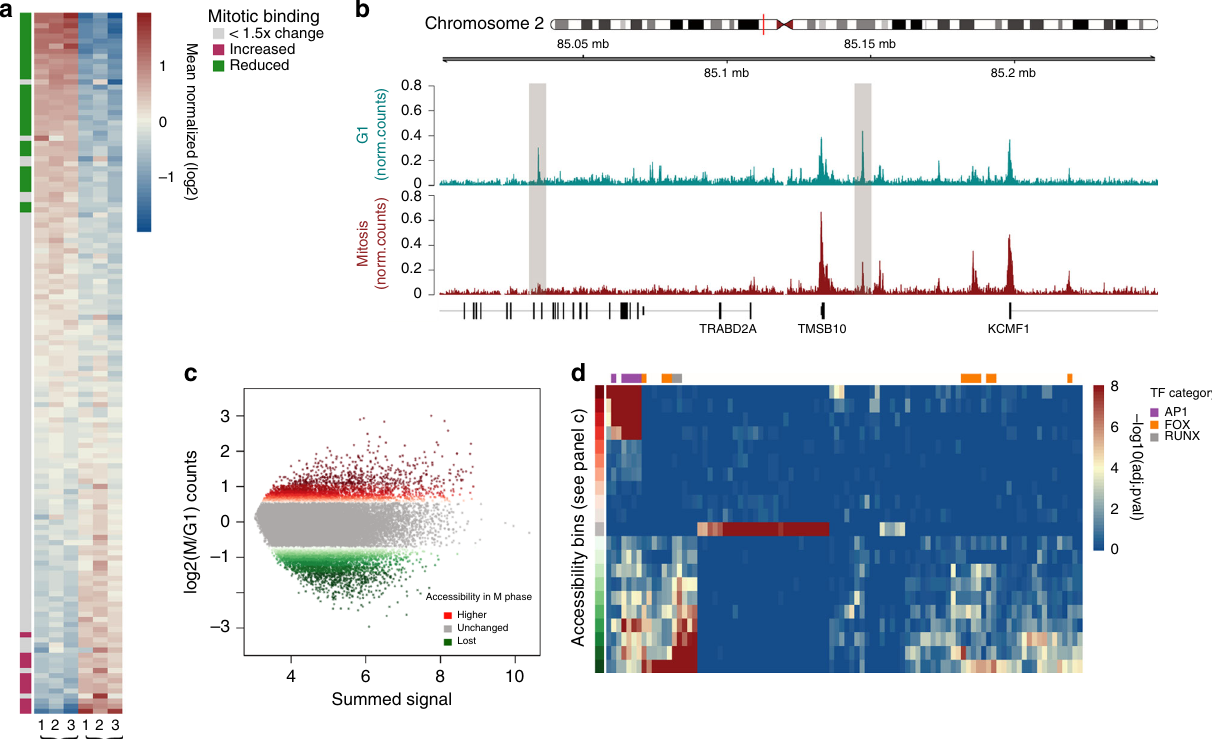
Fig. 5 The regulatory landscape is largely retained on mitotic chromosomes. a Transcription factor binding dynamics between G1- and M-phase. Scale is mean normalized in log2 space. Factors signi fi cantly depleted in M-phase are indicated by the green annotation row and signi fi cantly enriched factors are denoted in red ( p ≤ 0.001 and 1.5-fold change, see Methods for signi fi cance determination). b Screenshot of a 150 kb region, illustrating large scale conservation of the regulatory landscape. Shaded boxes represent local depletions in accessibility in mitosis. Scale is read counts normalized to library size. c Binning of distal peaks based on difference in accessibility between G1 and mitosis. Green and red points represent bins of reduced and increased accessibility in mitosis, respectively, while gray points represent unchanged peaks. d Enrichment of transcription factor motifs in bins shown in (c). Scale is − log10(adjusted p- value). Annotation column on top of the heatmap denotes transcription factors of the Fox and Runx families as well as AP1. Bins from panel (c) are represented by the annotation column on the far